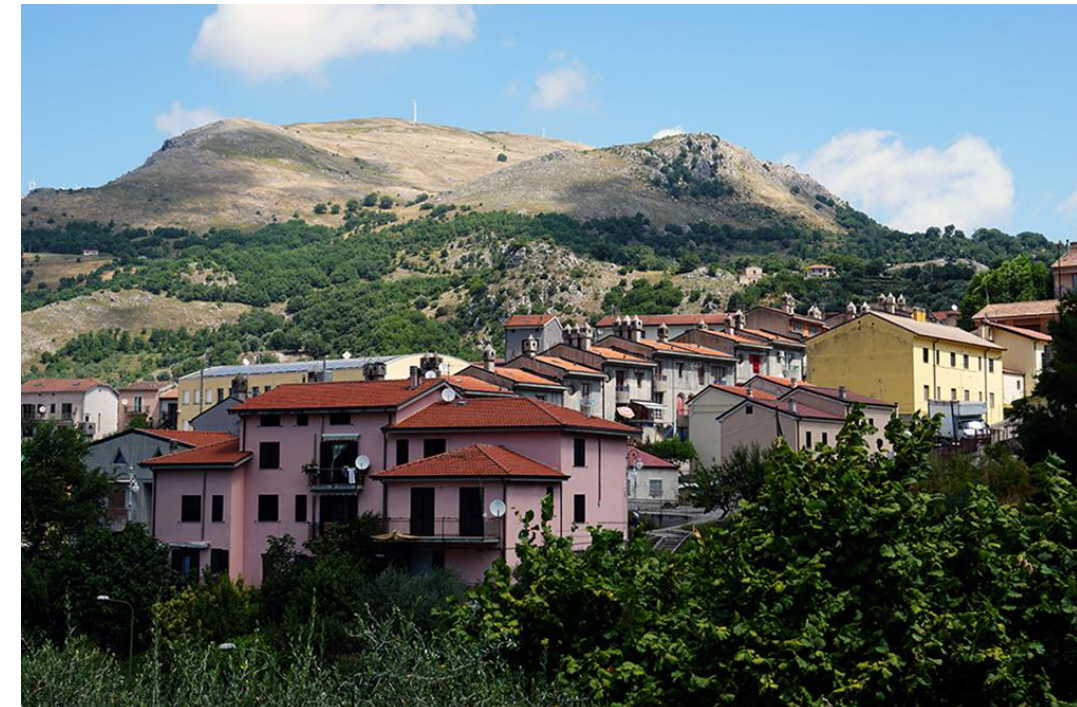
Figure 41. Balvano: overview of new buildings (photos by [35,36]).